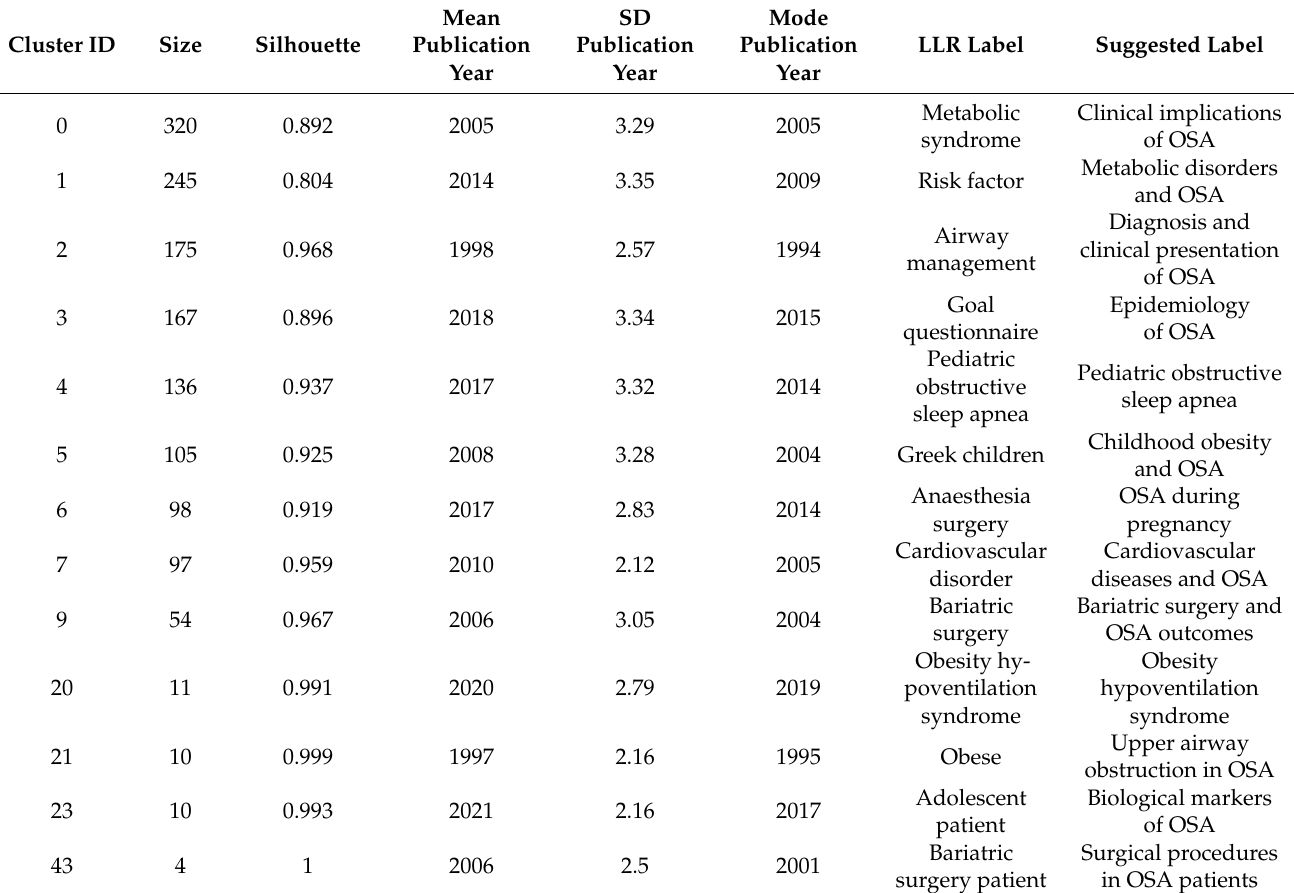
Table 1. Metrics of the 13 clusters identified with the document co-citation analysis (DCA). Log- likelihood ratio (LLR) labels are automatically generated by the